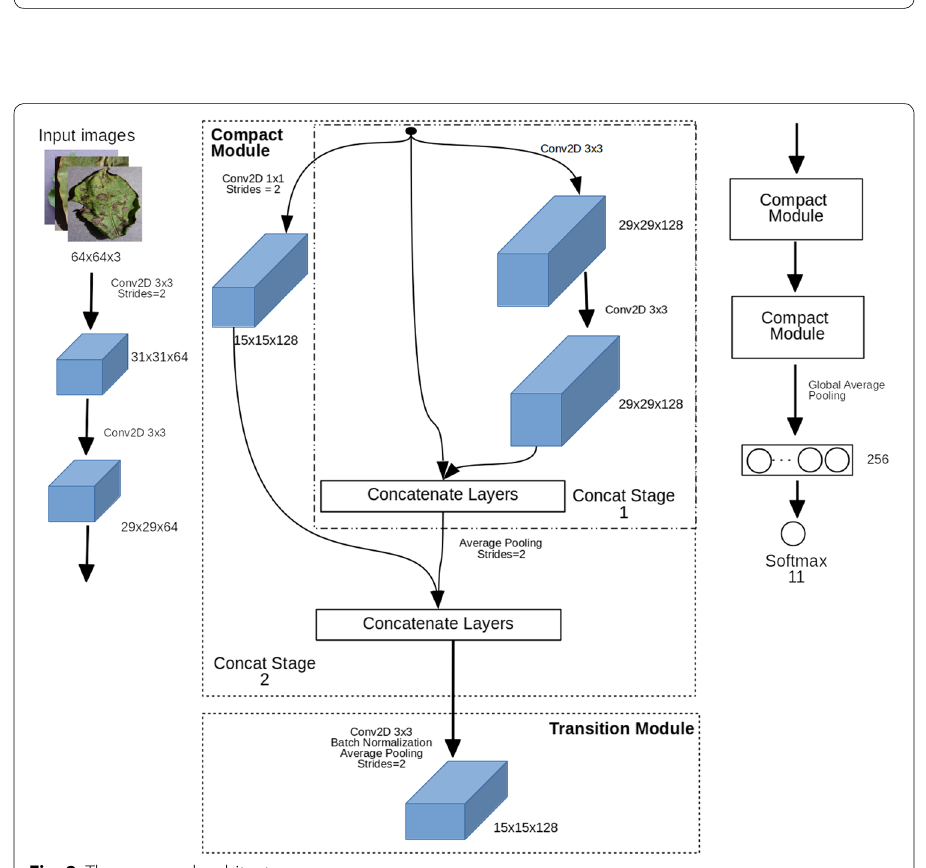
Fig. 8 The proposed